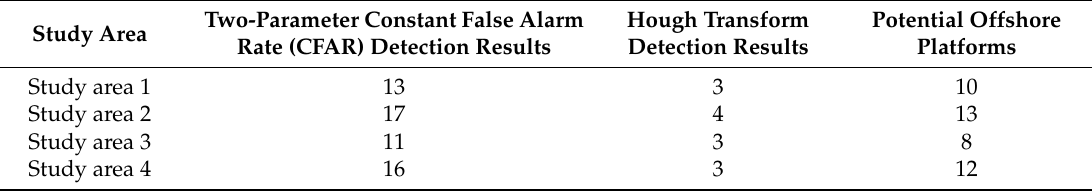
Table 4. Extraction results in the study